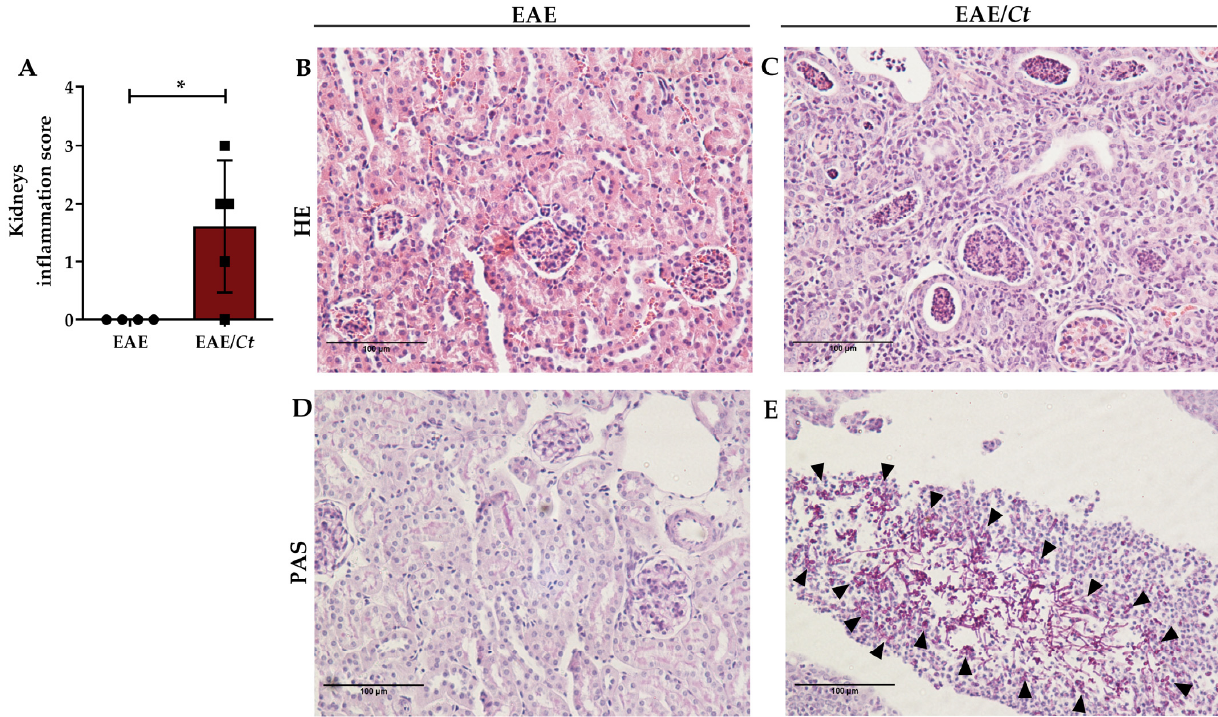
Figure 7. Effect of C. tropicalis infection on kidneys of EAE mice. Female C57BL/6 mice were infected with 1 × 10 6 viable C. tropicalis yeasts three days before EAE induction and evaluated for renal parenchyma impairment ( A – C ) and presence of yeasts ( D , E ) in kidney samples. Representative images of each group. The results are expressed as mean ± SD; * p < 0.05.